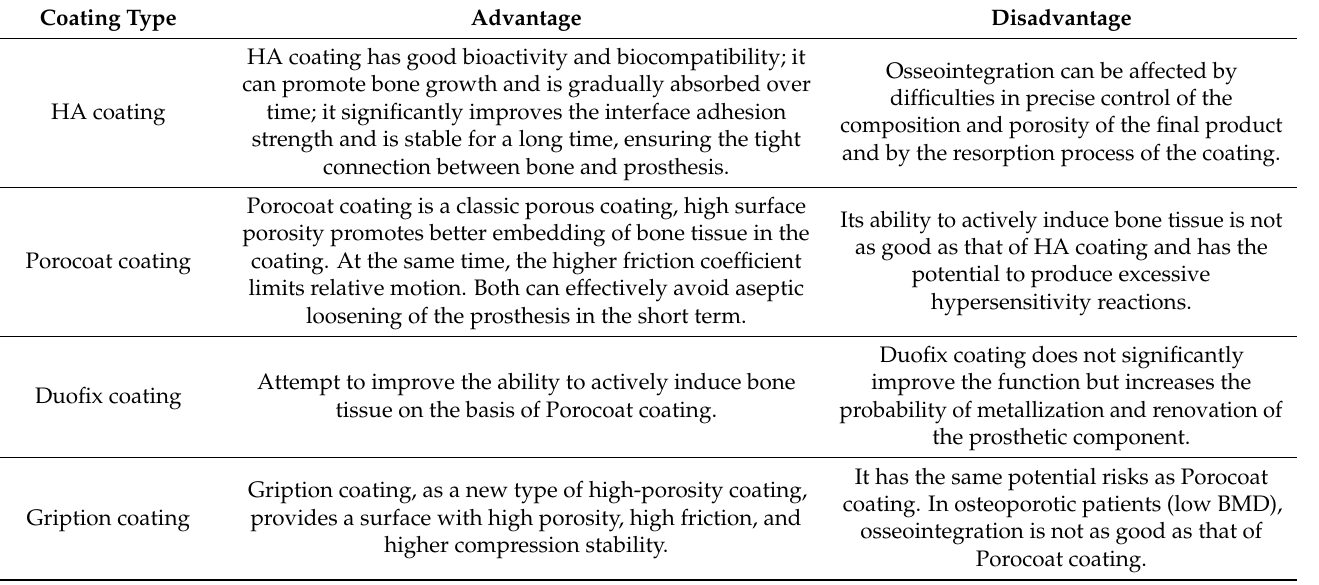
Table 2. Advantages and disadvantages of